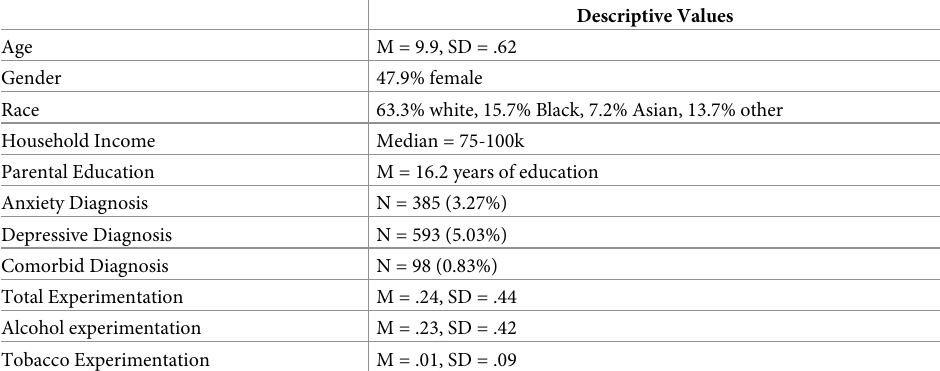
Table 1. Descriptive statistics of children in the ABCD study (N =